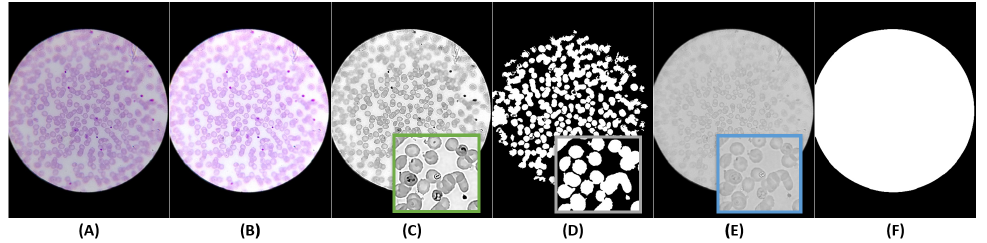
Figure 6. Pre-processing: ( A ) original image; ( B ) brightness and contrast adjustment; ( C ) sharpening applied over green channel of adjusted image; ( D ) RBCs; segmentation applied over the sharpened image; ( E ) blue channel of the original image; ( F ) optical circle segmentation applied over the blue channel of the original